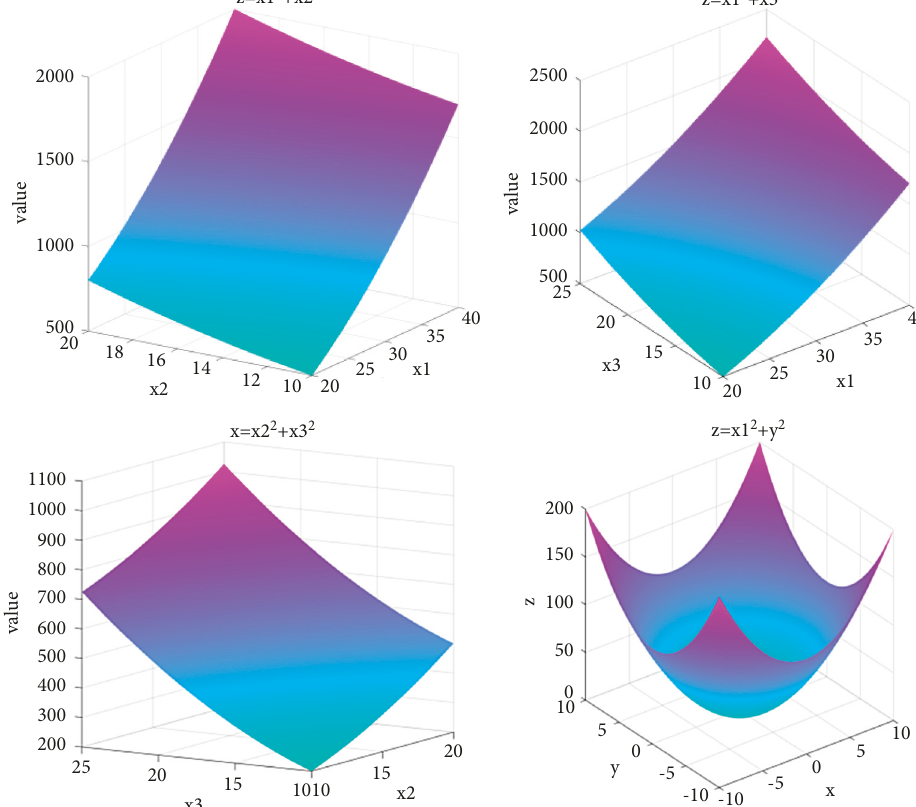
Figure 10: Diagram showing the data relationship between agricultural influencing